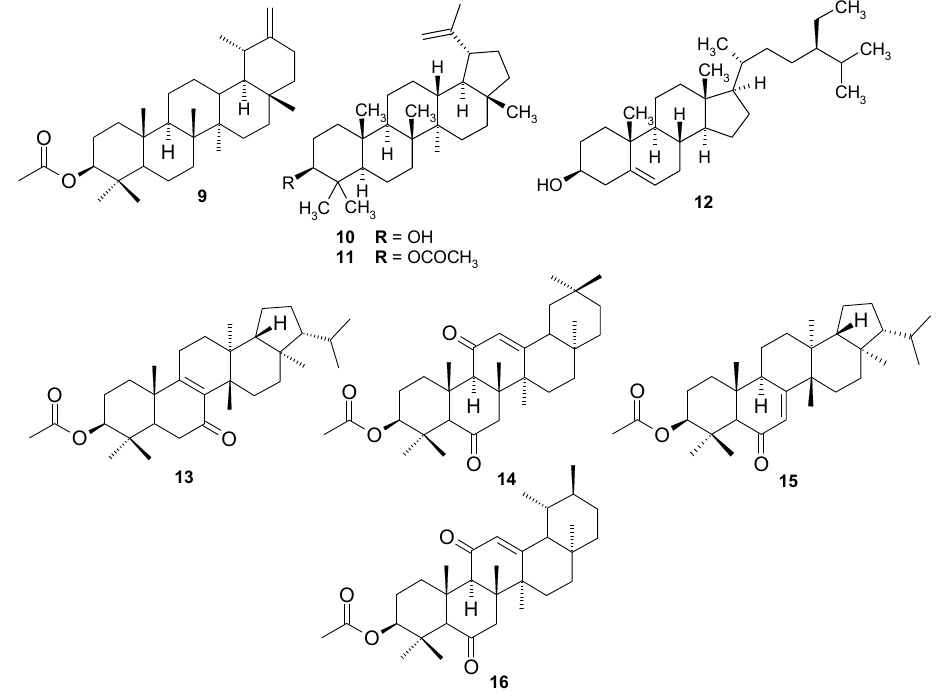
Figure 6. Terpenoid constituents of Scorzonera species found in Scorzonera extracts and tested for TNF- α production inhibition.